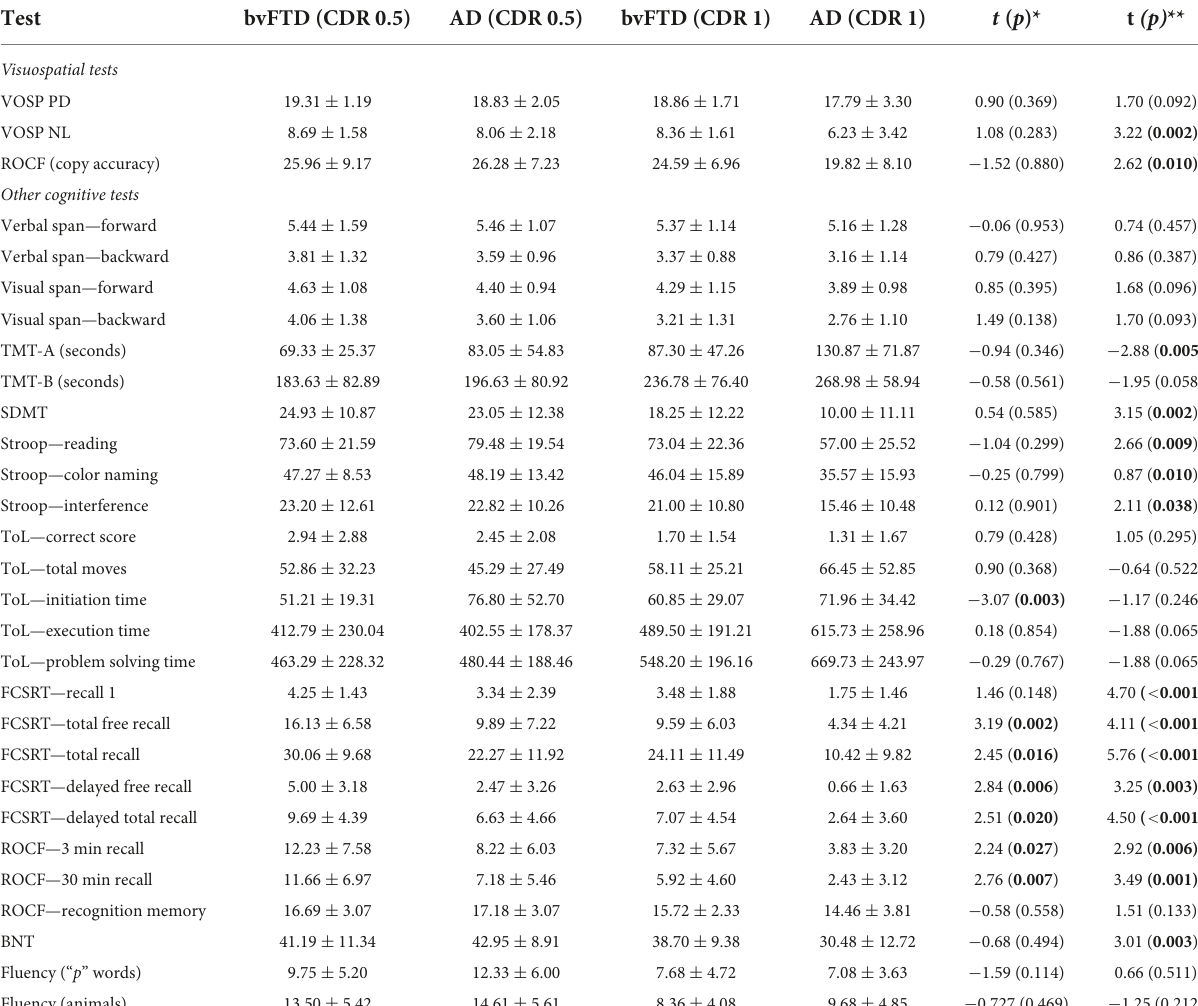
TABLE 2 Neuropsychological profile of bvFTD and